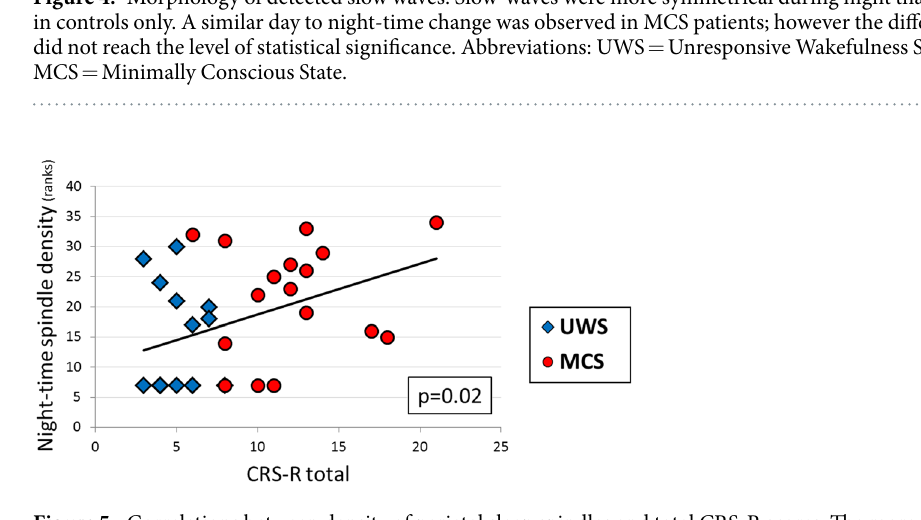
Figure 5. Correlations between density of parietal sleep spindles and total CRS-R scores. The more parietal spindles during night-time the higher CRS-R scores. Each dot on the graph corresponds to one patient (N = 34). Correlations were calculated for ranked values. Abbreviation: CRS-R = Coma Recovery